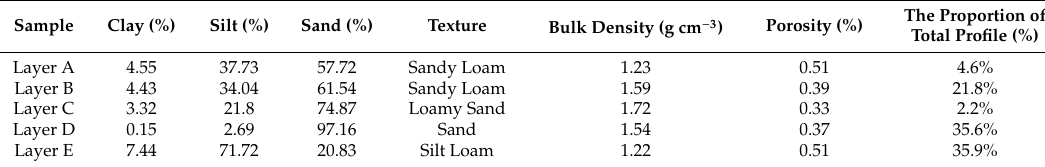
Figure 1. The location of the research area and a typical natural profile. Table 1. Physical properties of the experimental